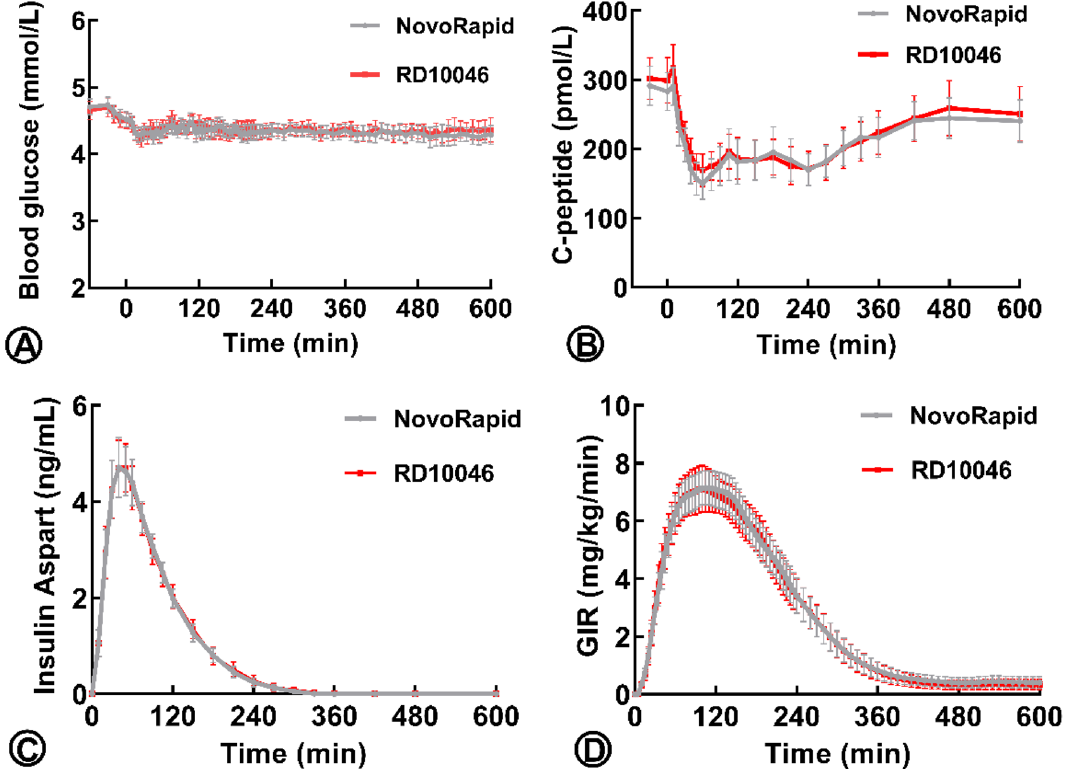
Figure 2. The mean value of clamped blood glucose ( A ), C-peptide ( B ), insulin aspart level ( C ), and glucose infusion rate (GIR) ( D ) in the RD10046 and NovoRapid group during the euglycemic clamps. The error bars represent the 95% confidence